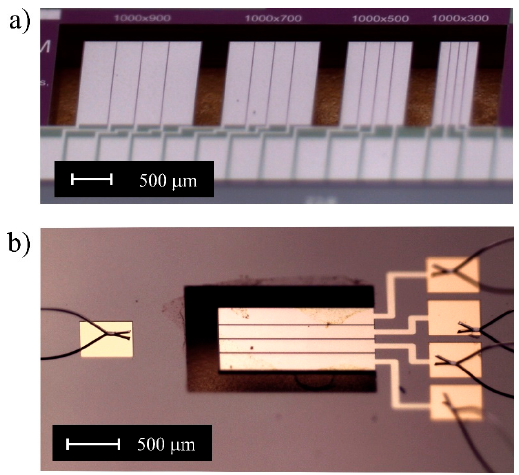
Figure 1. Optical micrograph of ( a ) a set of 1000 µm-length and 10 µm-thick cantilevers with different widths from 300 to 900 µm and ( b ) a 40 µm thick cantilever with a length of 1500 µm and a width of 700 µm. The top electrode is split in four stripes that can be accessed individually with respect to the common bottom electrode. All of them are wire bonded to a standard dual in-line package (DIP).